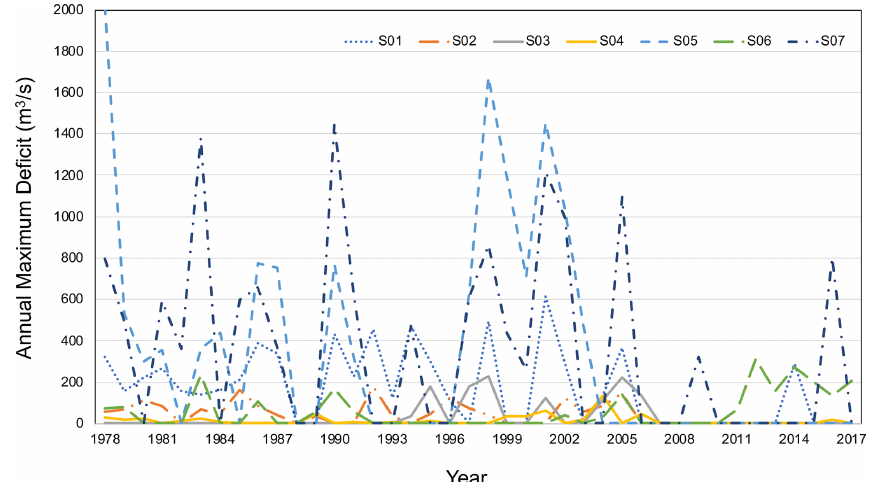
Figure 10. Time series of the annual maximum deficit (m 3 s − 1